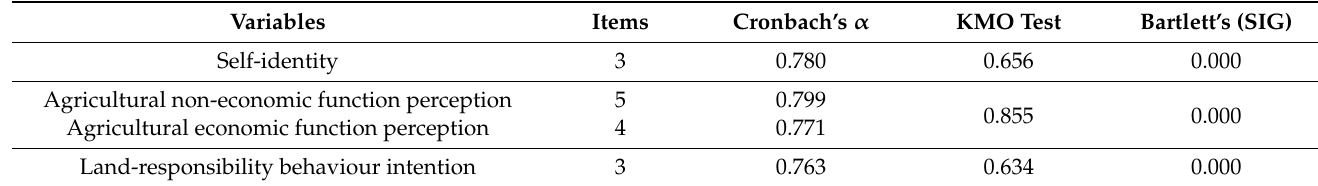
Table 2. Reliability estimations for the questionnaire.